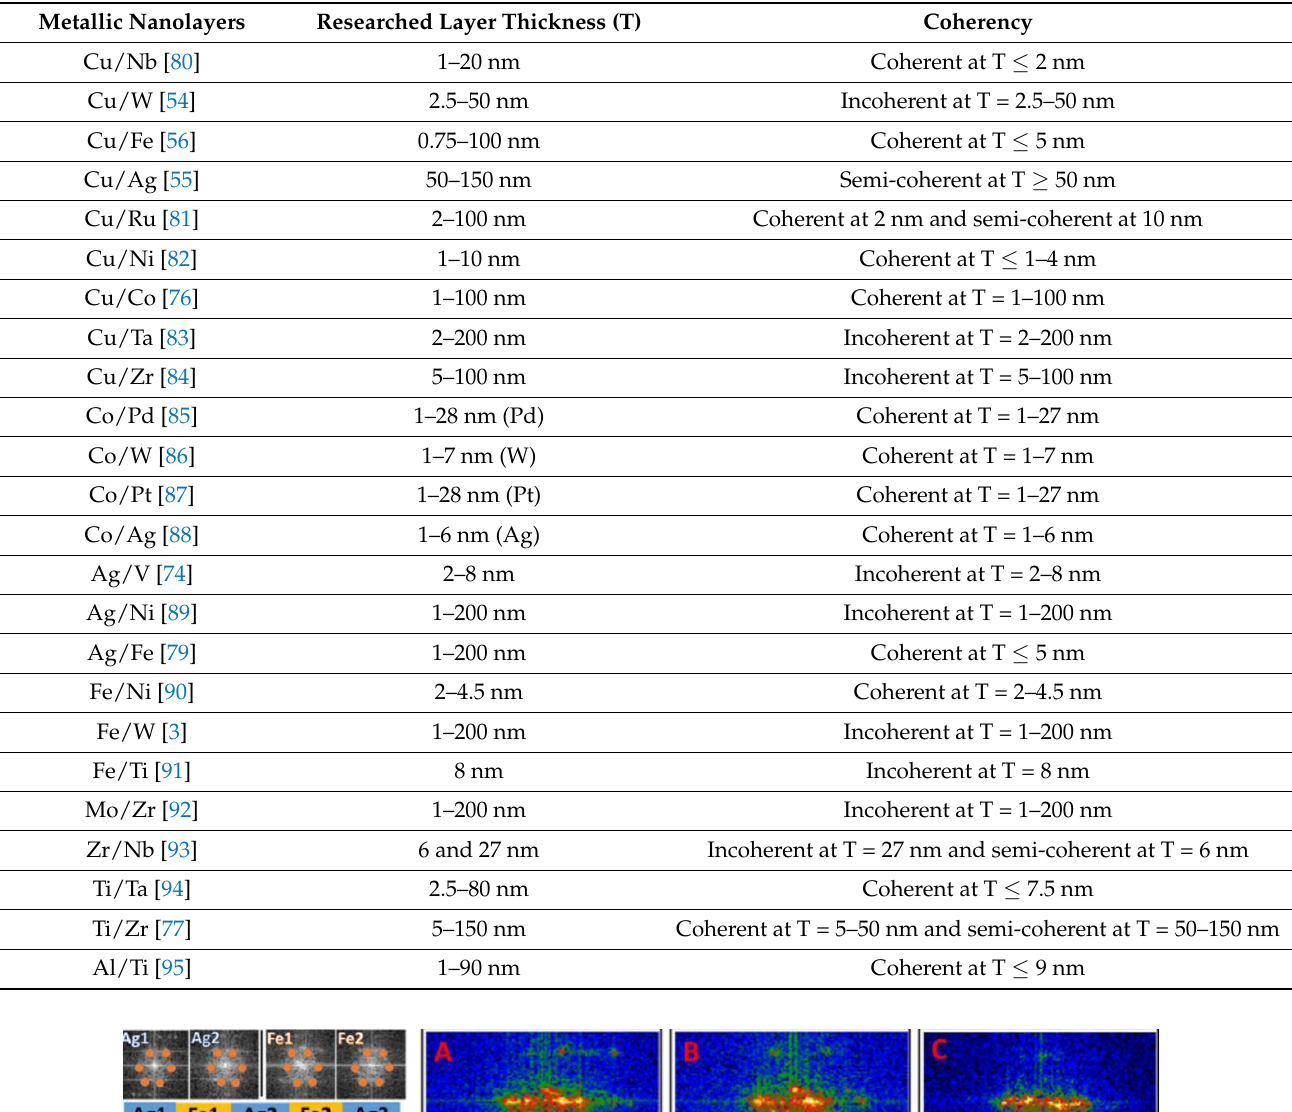
Table 4. A summary of the coherency between layers of various multilayer films.